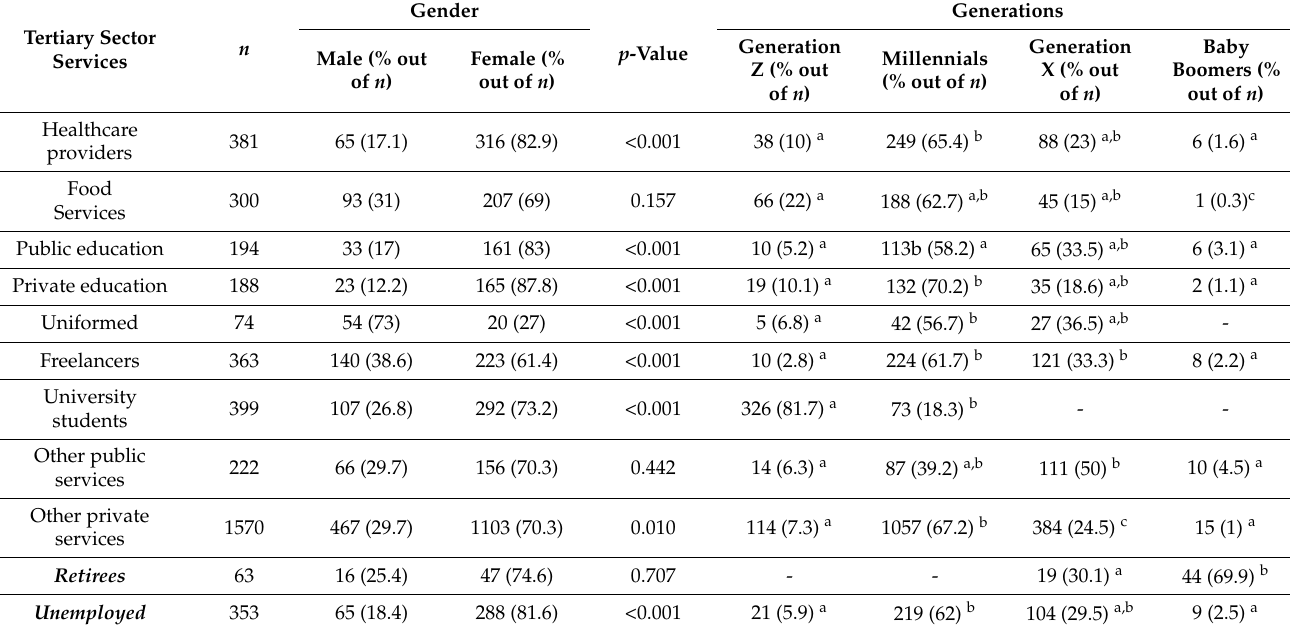
Table 1. Distribution of genders and generations by tertiary sector services.